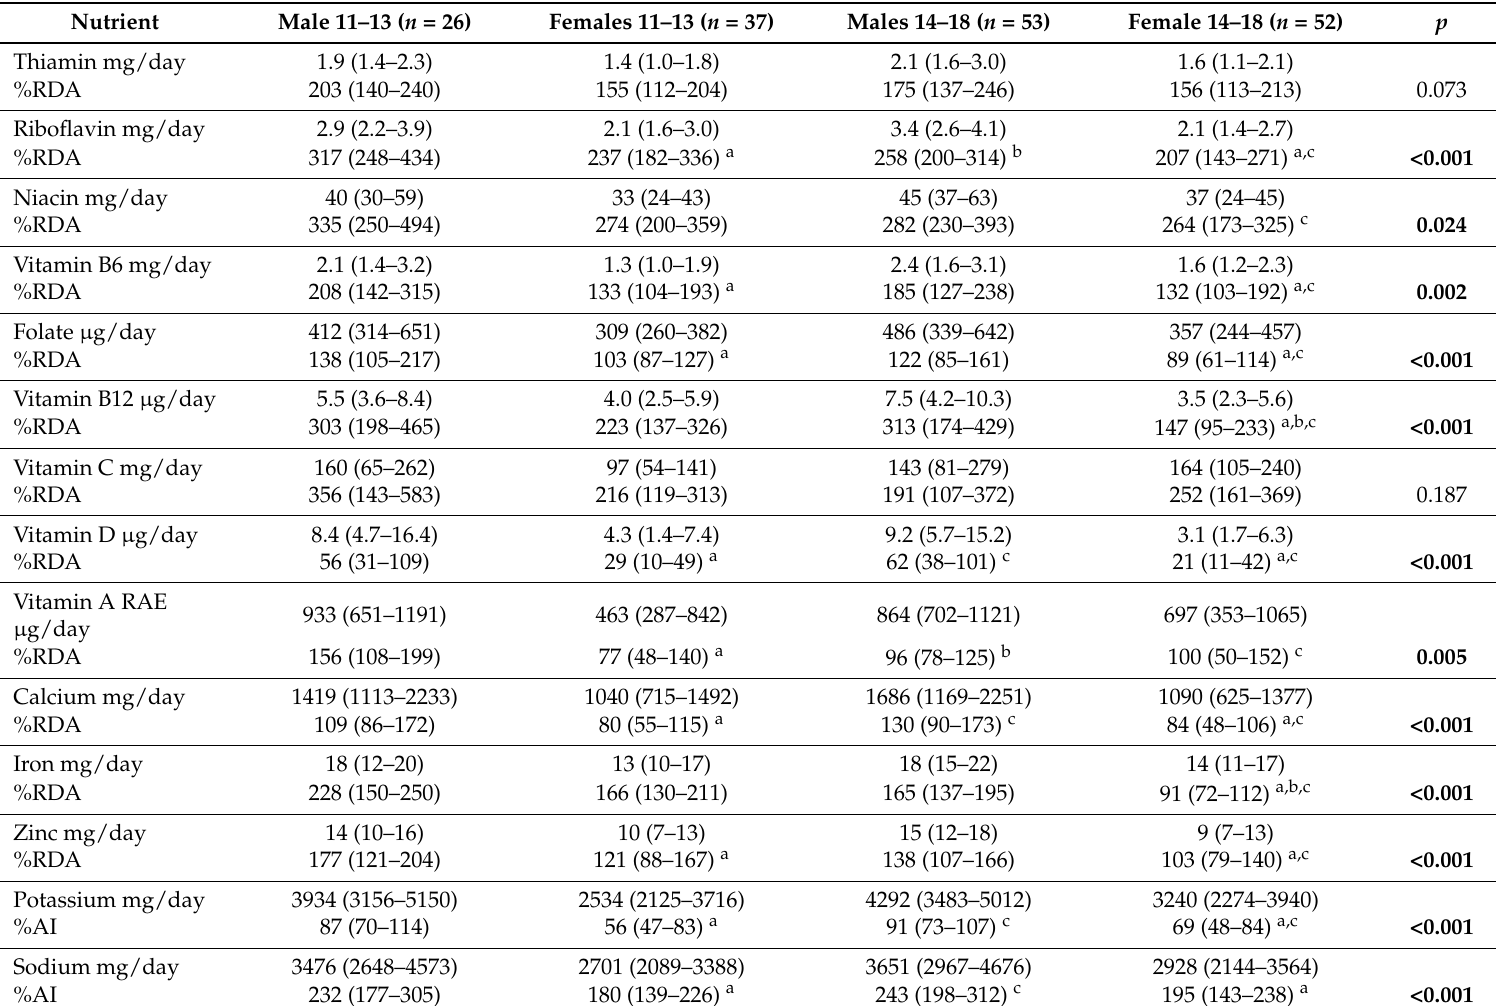
Table 3. Micronutrient intakes from food